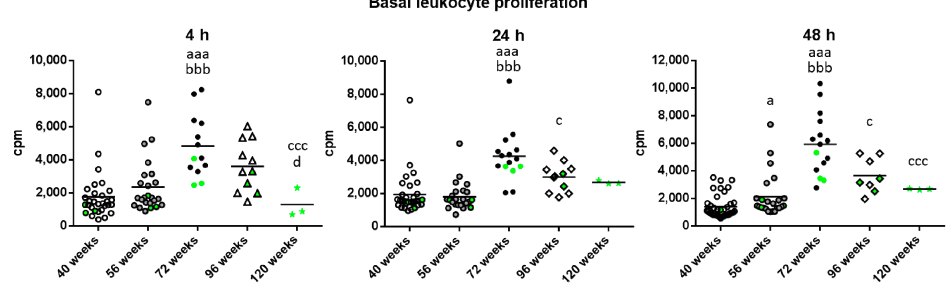
Figure 4. Basal proliferation (cpm) of peritoneal leukocytes from adult (40 weeks), mature (56 weeks), old (72 weeks), very old (96 weeks) and long-lived (120 weeks) mice, after 4, 24 and 48 h of culture. The green points represent the values in mice that reached 120 weeks. a: p < 0.05; aaa: p < 0.001 with respect to the value in adult mice. bbb: p < 0.001 with respect to the value in mature mice. c: p < 0.05; ccc: p < 0.001 with respect to the value in old mice. d: p < 0.05 with respect to the value in very old mice.